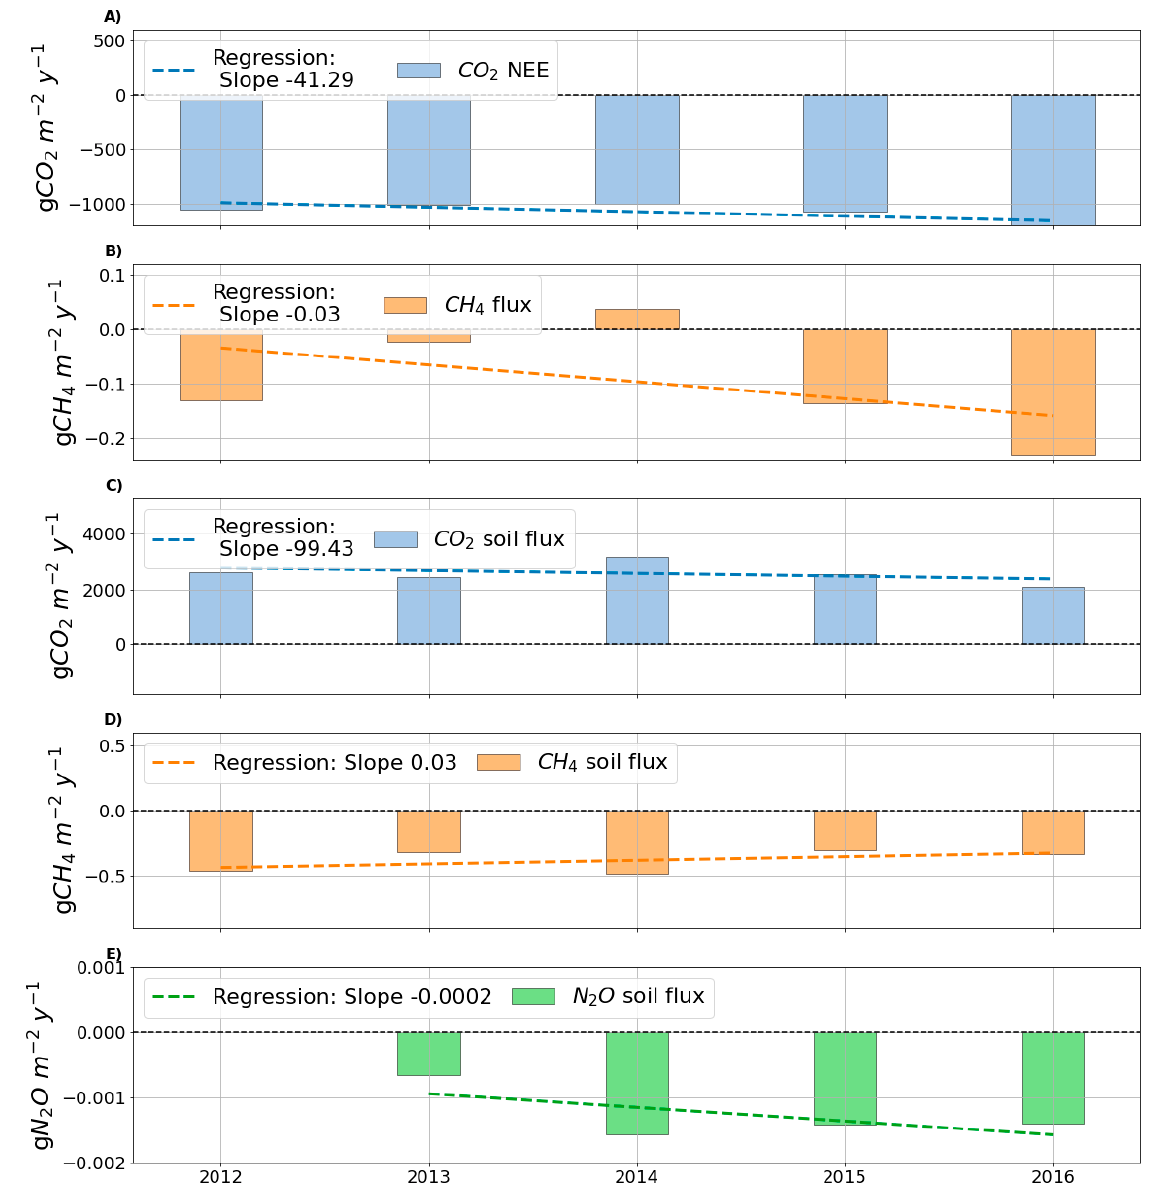
Figure 4. Yearly budgets (bars) and trends (lines) for CO 2 ( A ) and CH 4 ( B ) fluxes measured at the top of the tower, and soil CO 2 ( C ), CH 4 ( D ) and N 2 O ( E ) fluxes measured at chambers no. 2 (CO 2 and CH 4 ) and no. 10 (N 2 O). Soil fluxes budgets from ( C – E ) correspond only to the period May–November, while the tower fluxes from ( A , B ) to the full year [38].